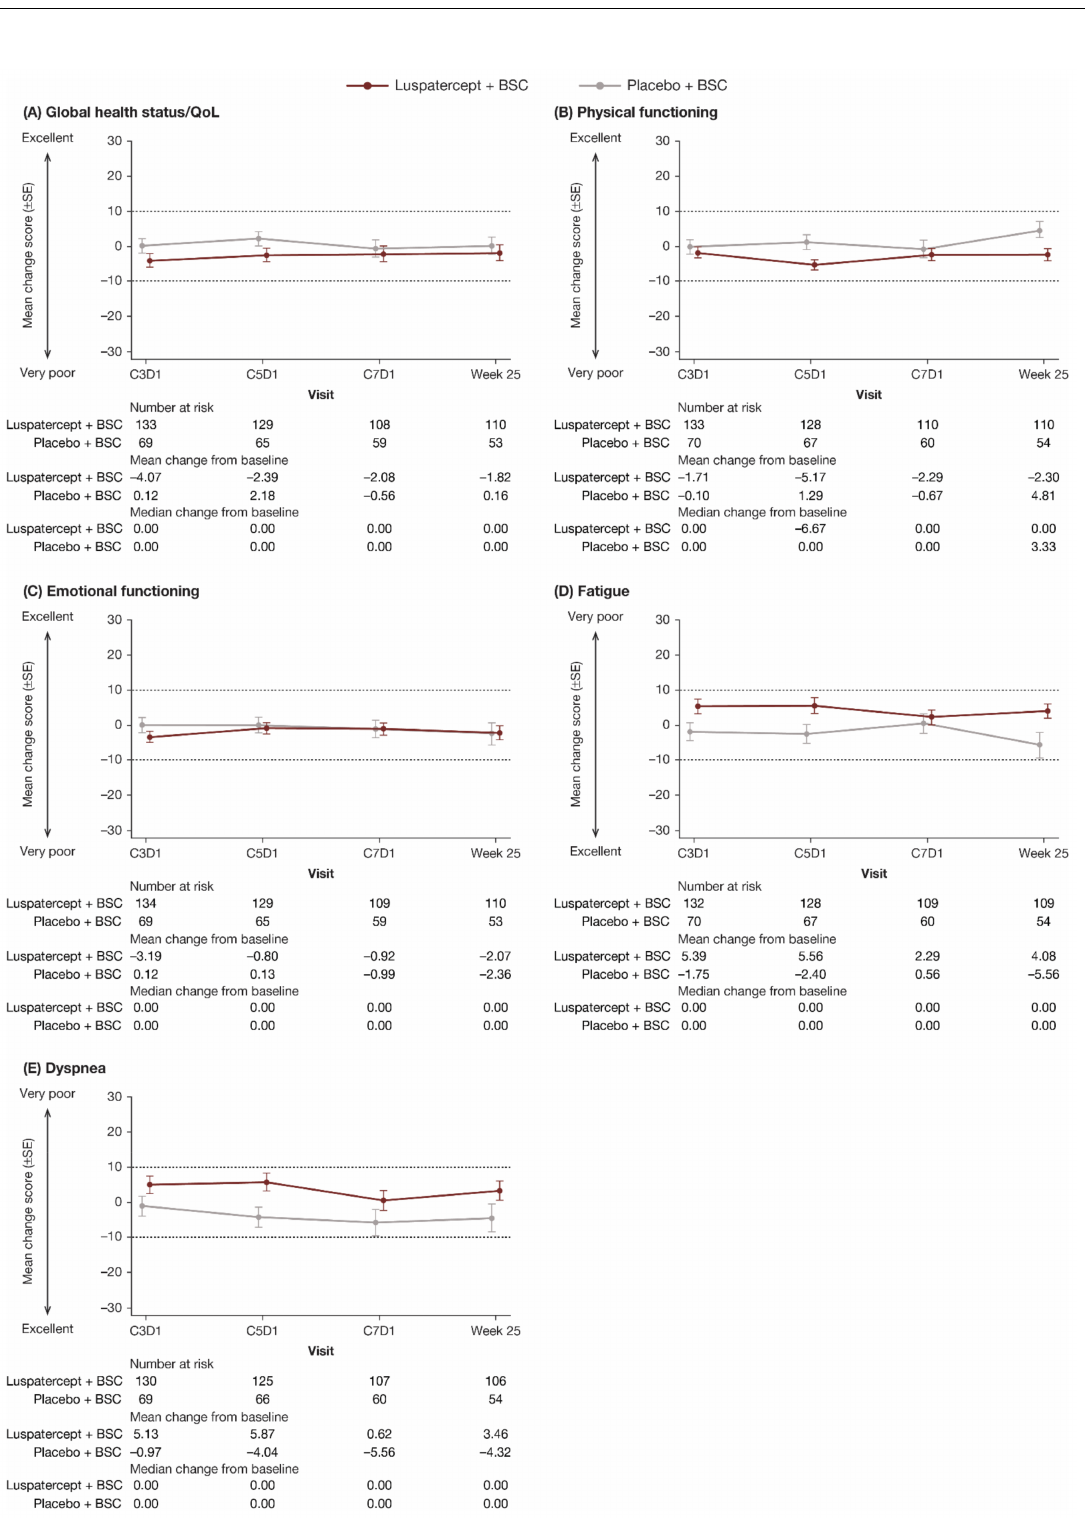
Figure 2. Observed mean change from baseline in patient-reported ( A ) global health status/QoL, ( B ) physical functioning, ( C ) emotional functioning, ( D ) fatigue, and ( E ) dyspnea scores through week 25 on the EORTC QLQ-C30. Dashed lines indicate threshold for a clinically meaningful difference. In ( A – C ), higher scores represent better QoL; in ( D , E ), higher scores represent worse QoL. BSC, best supportive care; C, cycle; D, day; EORTC QLQ-C30, European Organisation for Research and Treatment of Cancer’s Core Quality of Life Questionnaire; QoL, quality of life; SE, standard